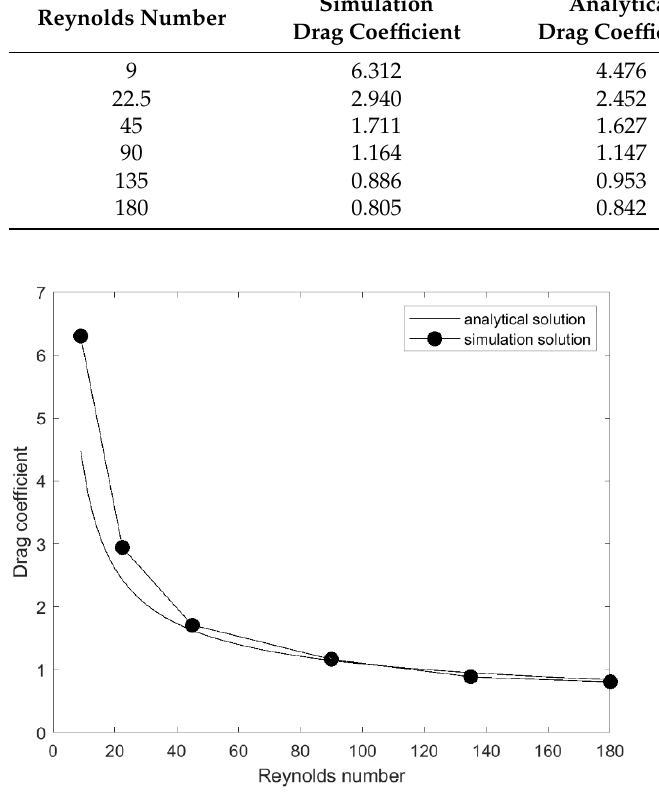
Figure 12. Drag coefficient with different Reynolds number.